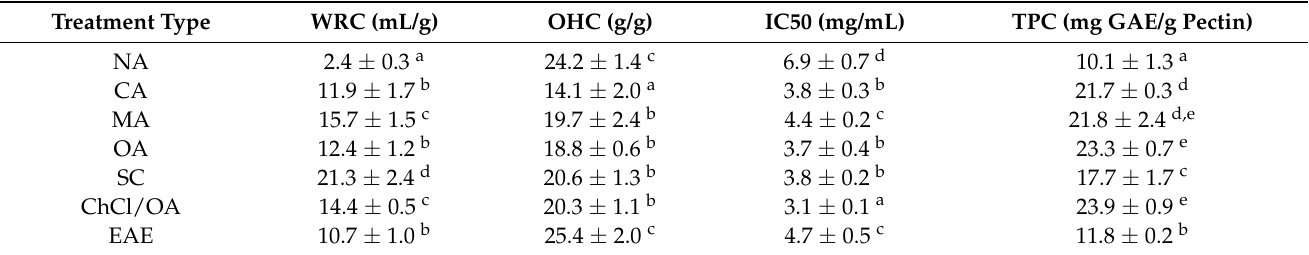
Table 4. Functional properties of GP pectin. NA (Nitric Acid), OA (Oxalic Acid), CA (Citric Acid), MA (Malic Acid), ChCl/OA (DES Choline Chloride/Oxalic Acid), SC (Sodium Citrate), EAE (Enzymatic- Assisted Extraction). WRC; Water Retention Capacity, OHC; Oil-Holding Capacity, IC50; Half inhibitory concentration, TPC; Total Phenolic